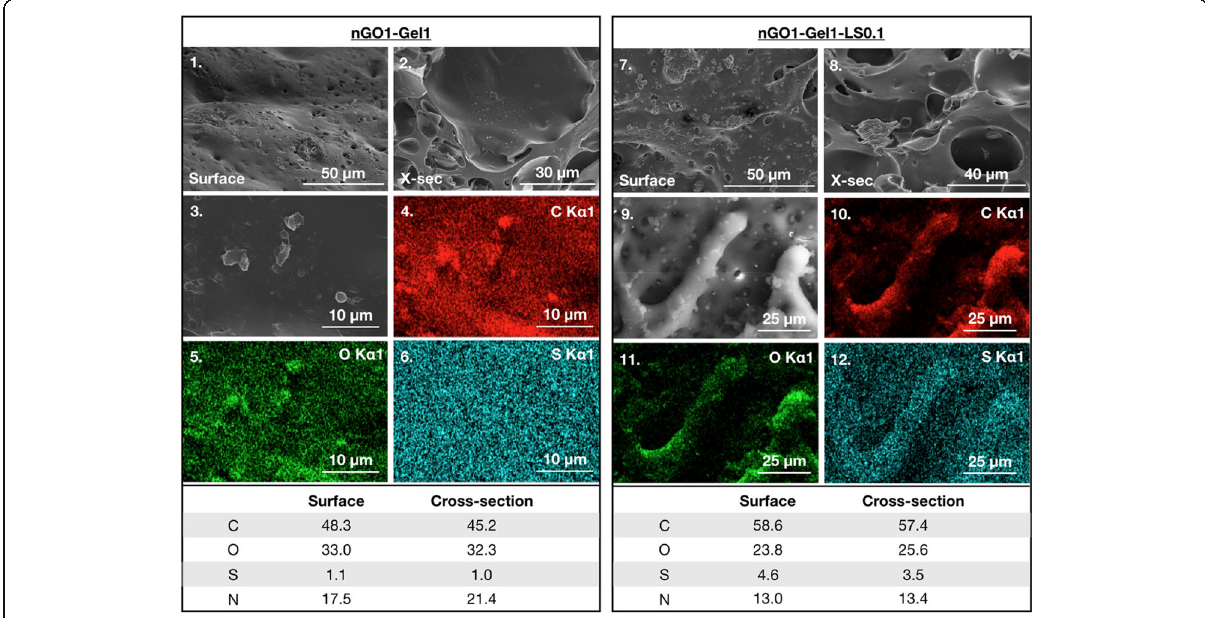
Fig. 3 SEM images and elemental maps (where carbon is represented in red, oxygen in green, and sulfur in blue) of non-functionalized nGO1- Gel1 (1 – 6) and lignosulfonate (LS)-functionalized nGO1-Gel1-LS0.1 (7 – 12) composites and their surface and cross-sectional elemental